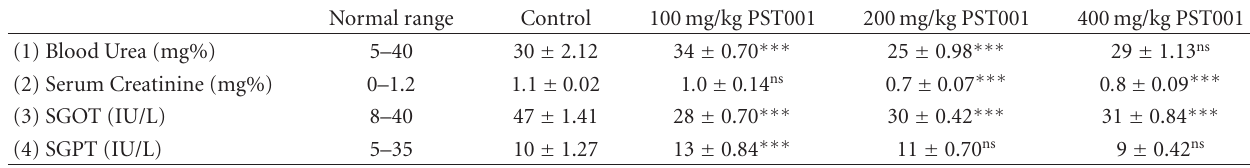
Table 9: E ff ect of PST001 on biochemical parameters in